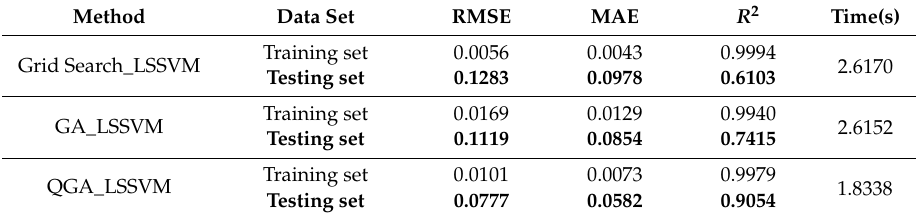
Table 13. The forecasting evaluation indexes of the current signal.